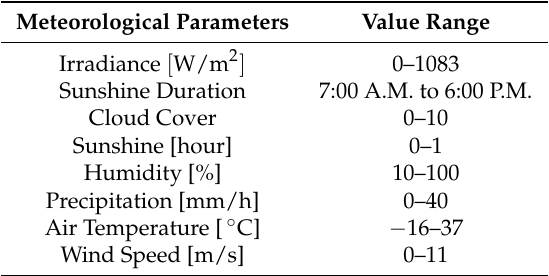
Table 1. Meteorological parameters and value range.